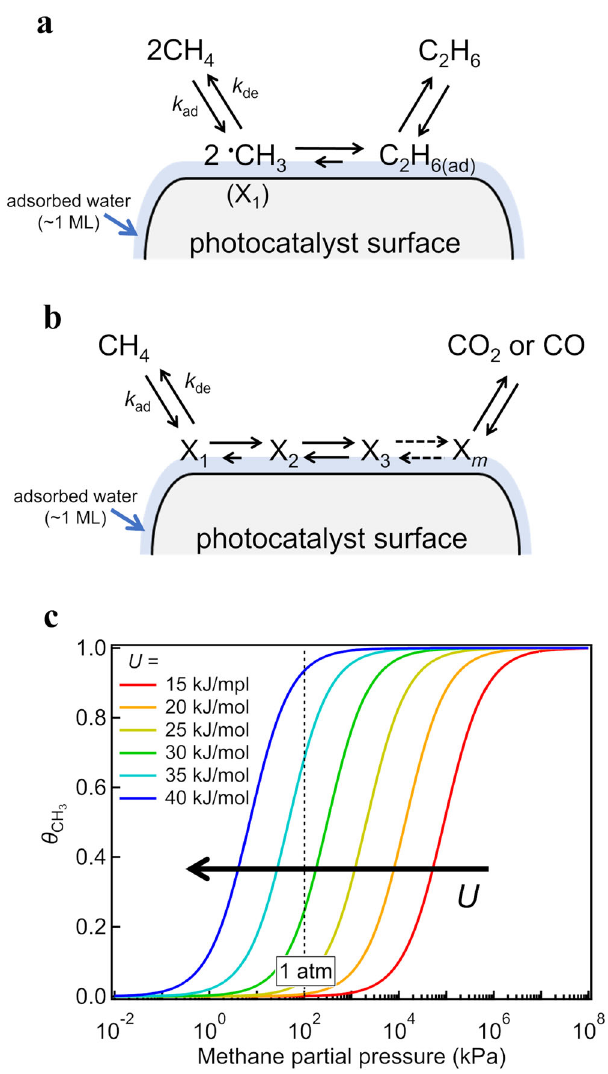
Fig. 5 Reaction scheme of the photocatalytic methane conversion. Surface reaction scheme of the photocatalytic conversion of methane to a C 2 H 6 and b CO 2 or CO. X i ( i = 1, 2, 3, … , m ) is a reaction intermediate; X 1 is the methyl radical ( (cid:129) CH 3 ). c Dependence of the coverage of rate-determining methane intermediates ( θ CH ) on P CH with various values of the stabilization energy 3 4 U . The horizontal axis is displayed on a logarithmic scale. Table 1 Stabilization energy of the methyl radical intermediate ( U ) for the photocatalytic C 2 H 6 , CO, and CO 2